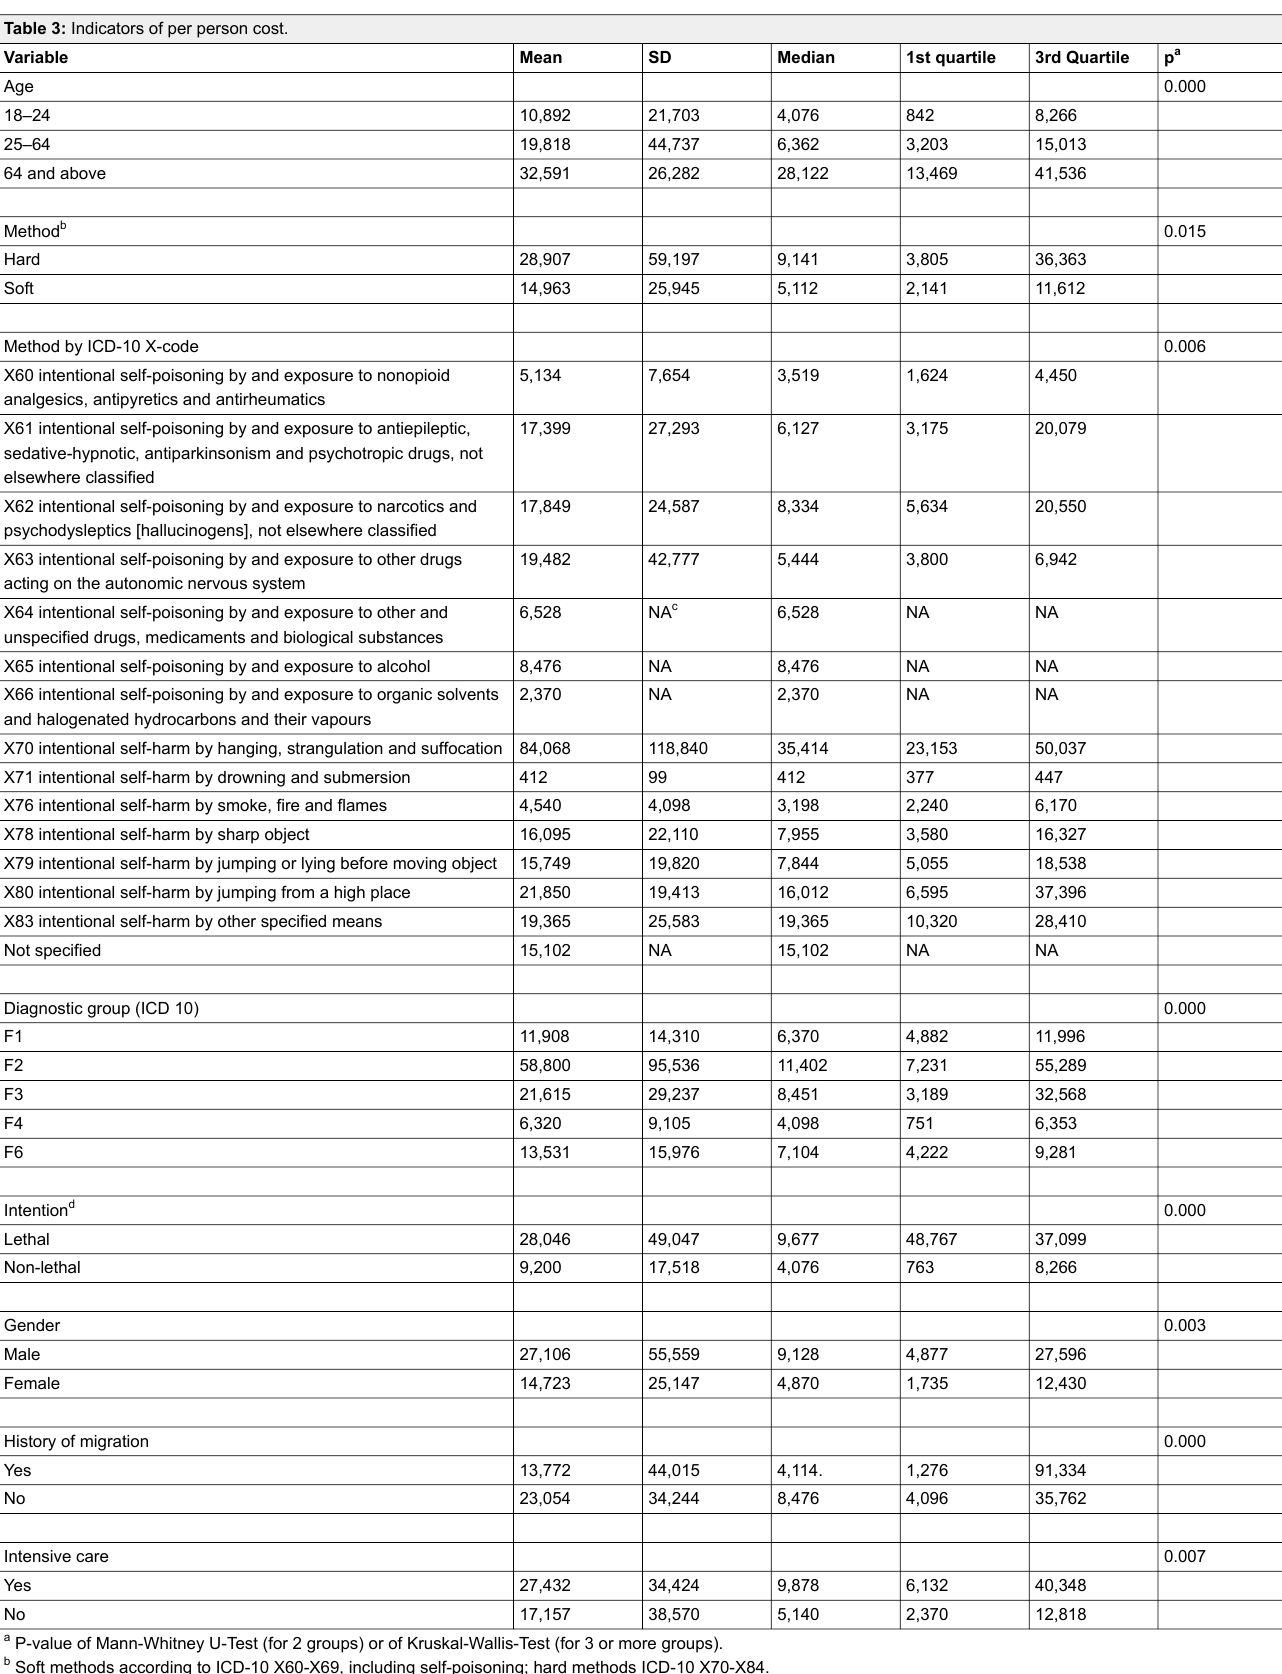
Table 3: Indicators of per person